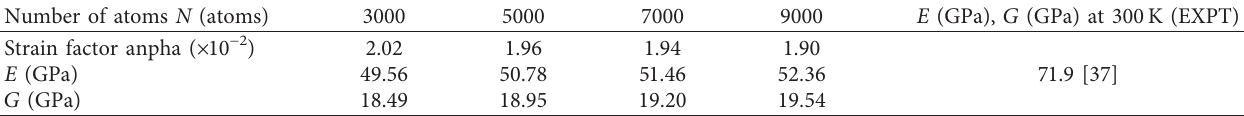
Table 4: Deformation of amorphous aluminium with different numbers of atoms.